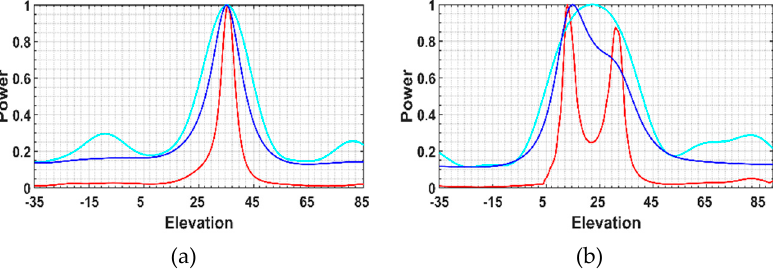
Figure 4. Pauli false color composite of master images of (a) TropiSAR and (b) AfriSAR data campaigns. Point A (ground pixel) and point B (forest pixel) are two analyzed cells. Figure 5. Span profiles of ground ( a ) and forest ( b ) pixels. Cyan, blue, and red are indicative of Beamforming, Capon, and the proposed method, respectively.